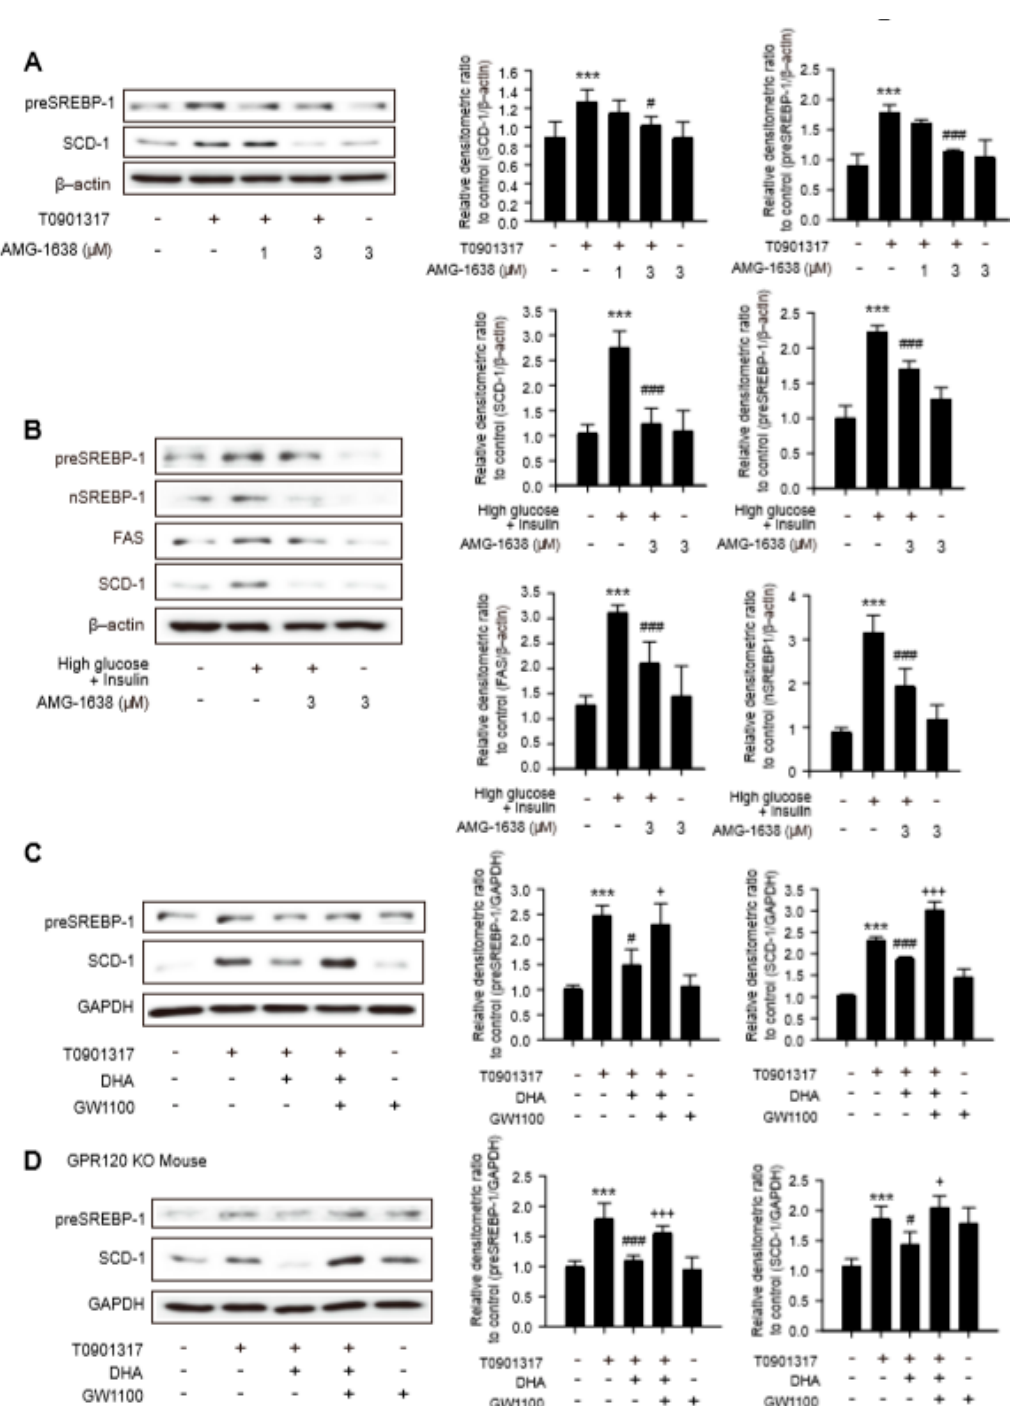
Figure 4. Role of GPR40 in expression of lipogenesis enzymes in hepatocytes. ( A ) Primary hepatocytes were treated with AMG-1638 (1 and 3 μ M) for 12 h followed by T090 for additional 12 h, and total cell lysates were subjected to immunoblotting for preSREBP-1 and SCD-1. Data represent means ± SD (n = 4), ***P < 0.005 compared with the control group; # p < 0.05, ### p <0.005 compared with the T090- treated group. ( B ) Inhibitory effects of AMG-1638 on the protein expression of lipogenic enzymes in high glucose and insulin condition. Primary hepatocytes were treated with 3 μ M AMG-1638 for 12 h followed by 30 mM high-glucose medium for 30 min and further incubation with 200 nM insulin for 24 h. Data represent means ± SD ( n = 4), *** p < 0.005 compared with the control group, ### p < 0.005 compared with the T090-treated group. ( C ) Primary hepatocytes were treated with DHA and 10 μ M GW1100, GPR40 antagonist for 12 h followed by 30 mM high-glucose medium for 30 min and further